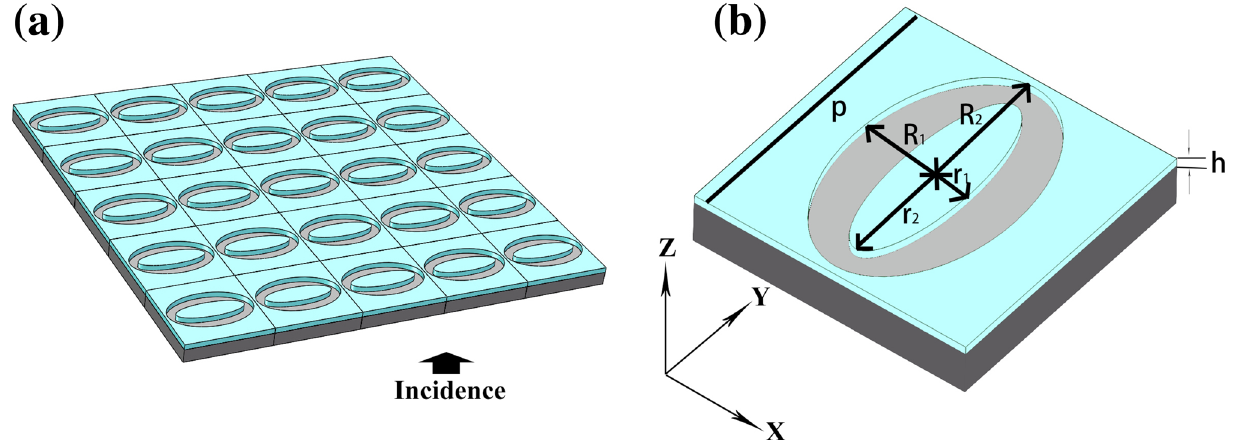
Figure 1. Structure of proposed NCQW. ( a ) Schematics of the proposed plasmonic metasurface NCQW structure (5 × 5 units). The light incidend from the substrate side as the arrow. ( b ) One unit of the proposed NCQW